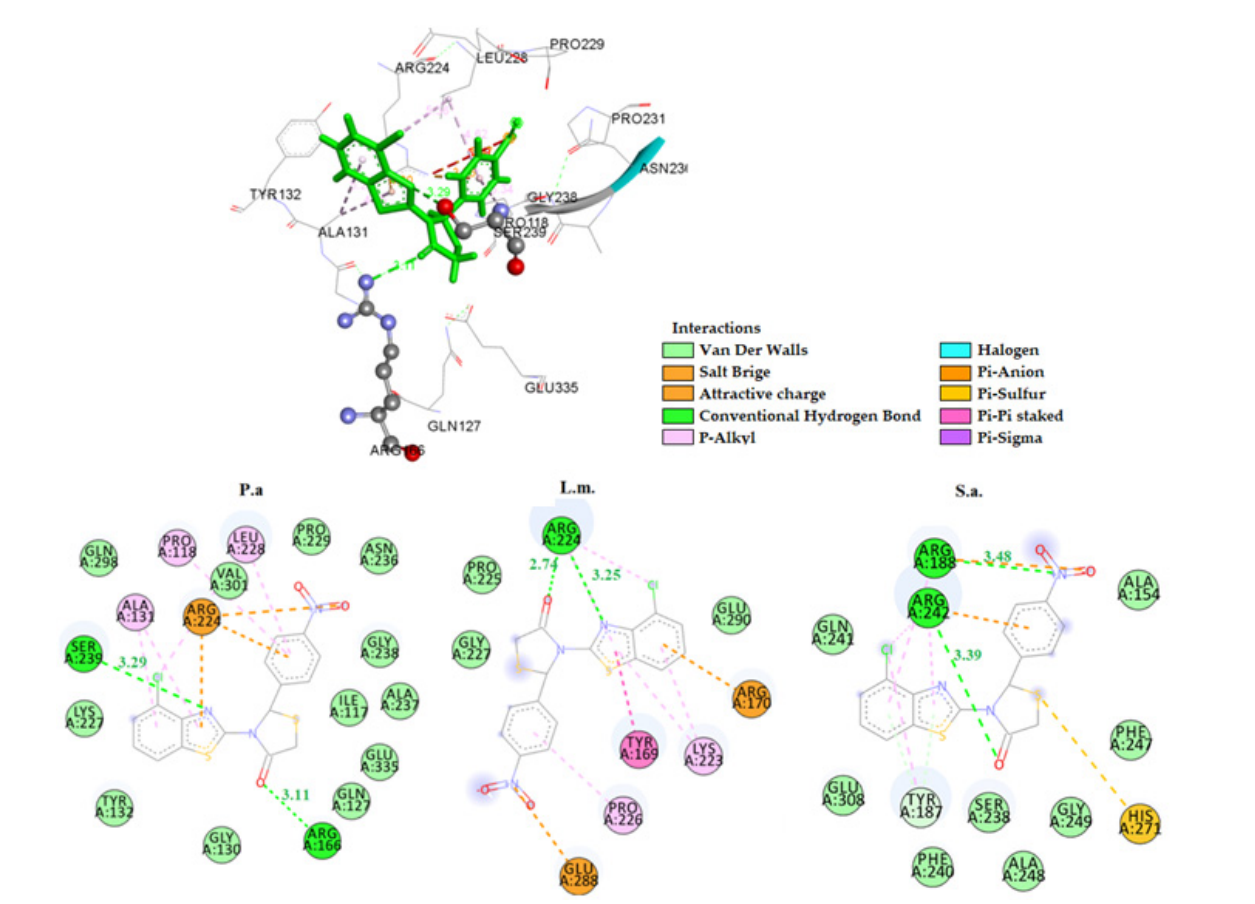
Figure 7. ( Above ) Binding pose of compound 5 (R-isomer) in the active MurB site of Pseudomonas aeruginos a (4JAY). ( Bottom ) 2D binding plots of compound 5 to MurB enzymes of Pseudomonas aeruginosa (4JAY), Listeria monocytogenes (3TX1), and Staphylococcus aureus (1HSK), ( left to right ). The binding of 5 to MurB of Listeria monocytogenes (3TX1) and Staphylococcus